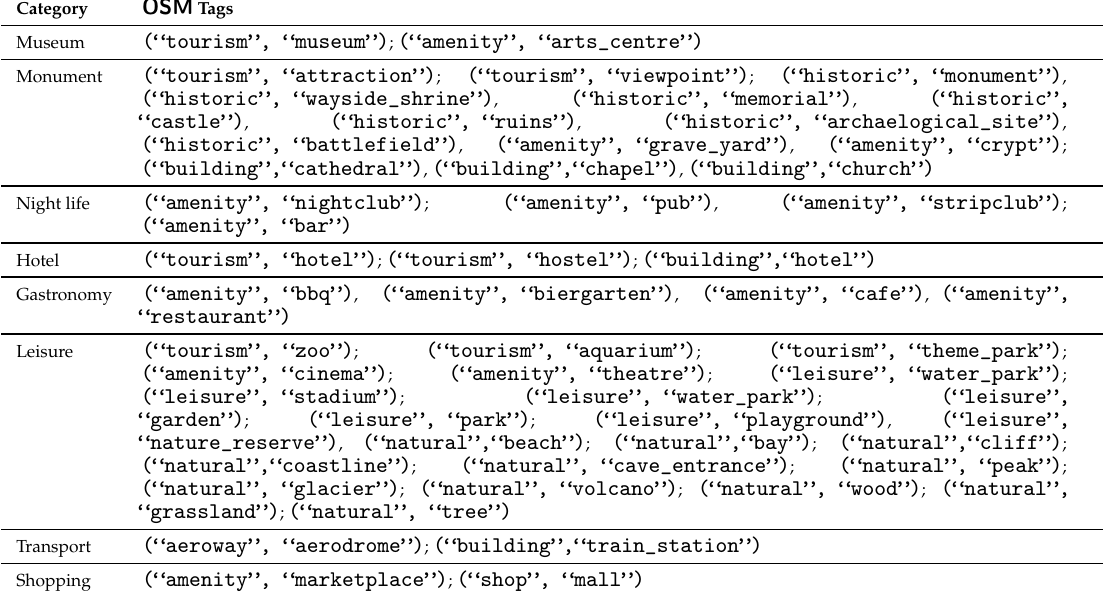
Table 2. OSM Tags and BITOUR